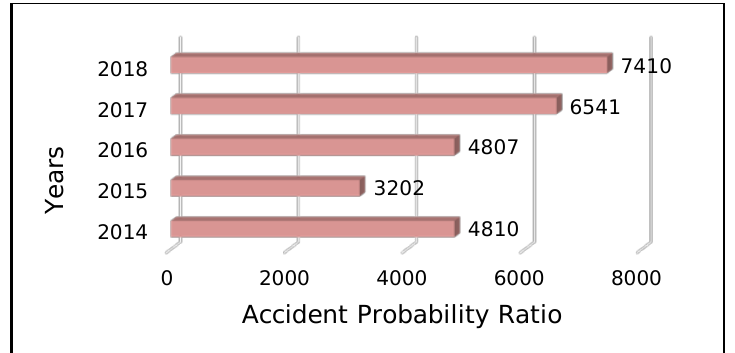
Figure 6. Accident Probability Ratio for the Years 2014 and 2018